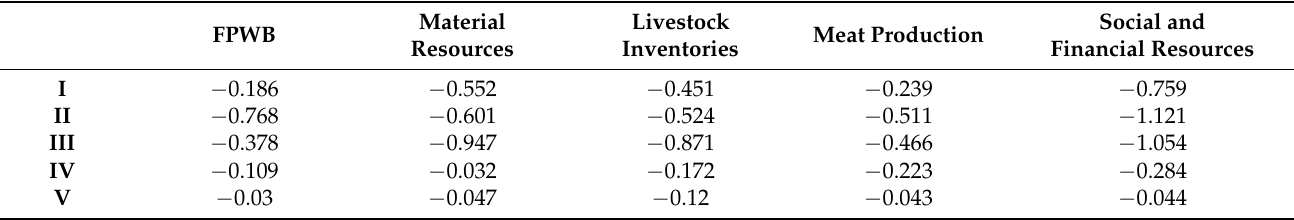
Table 5. Contribution of variations of the risk of snow disasters to the